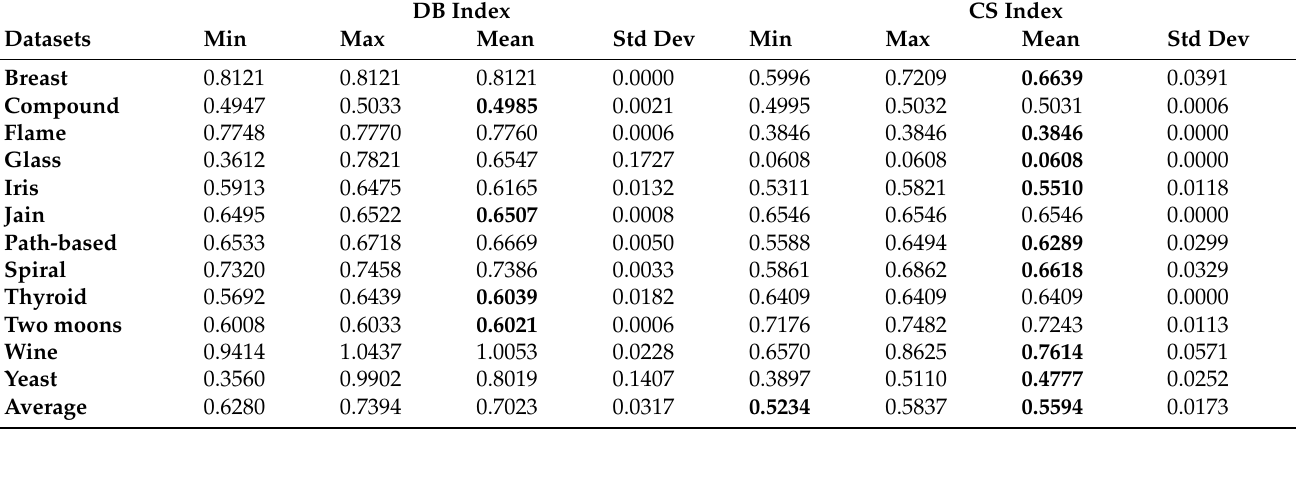
Table 4. Computational results for improved SOSK-means on 12 real-life datasets.